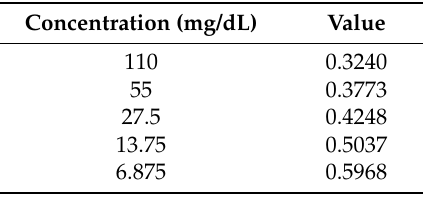
Table 2. Light reflection signal values of dry chemical diagnostic reagents in different